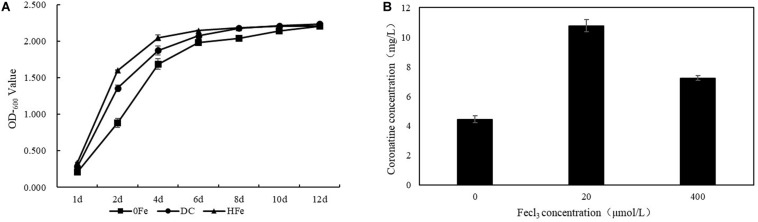
The OD600 value and the coronatine production of DC3000 under different FeCl3 concentration fermentation conditions. (A) The OD600 values of the three groups researched in the study were detected by ultraviolet spectrophotometer at OD600 after inoculation in fermentation medium. (B) The coronatine production of the three groups was measured at 10 days after inoculation in fermentation when the yield of the fermentation culture was stable. The mean was taken from three biologically independent replicates.